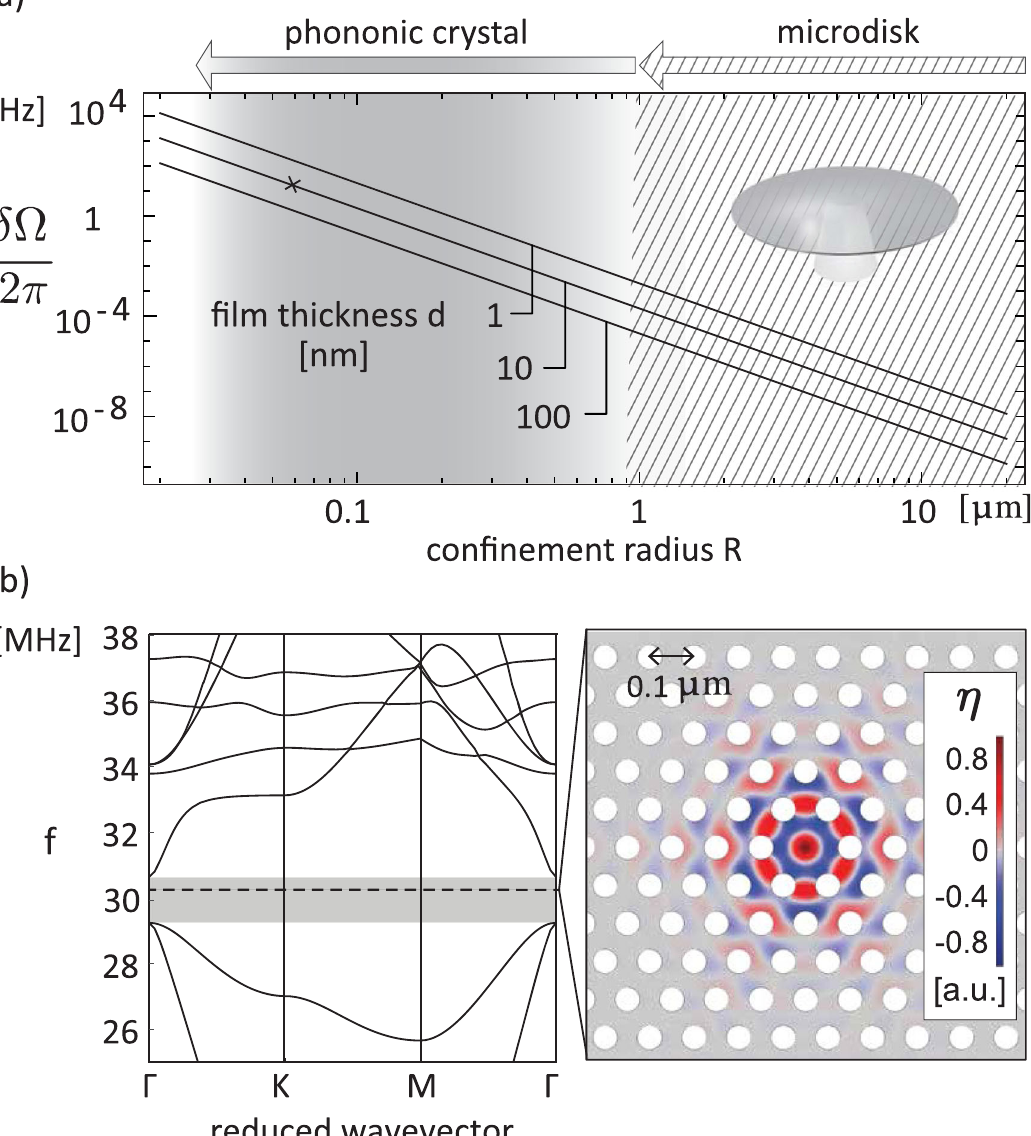
Fig. 6 Radial dependence of single-phonon shift and band structure phononic crystal. a Resonance frequency shift induced by a single = _ as a function of mode con fi nement radius R for various super fl uid fi lm thicknesses d for the ( μ = 0; ν = 1) mode. The phonon δ Ω ¼ 3 α eff x 4 zpf quantized nature of the anharmonic oscillator energy spectrum is resolvable if the mechanical linewidth Γ < δ Ω . Hatched: con fi nement radii for microdisks 38 – 40,49 . Gray shaded: con fi nement radii achievable through phononic crystal (PnC) trapping. X-mark: mode con fi ned in PnC cavity with lattice constant 100 nm. b PnC band structure and complete band gap (gray shaded) for a hexagonal honeycomb lattice with holes 55 nm in diameter, lattice constant 100 nm, and the van der Waals coef fi cient for silicon a vdw = 3.5 × 10 − 24 m 5 s − 2 (ref. 60 ). A central defect (absence of hole) introduces a Bessel-like mode at 30 MHz — within the band gap — as shown by the fi nite-element-method